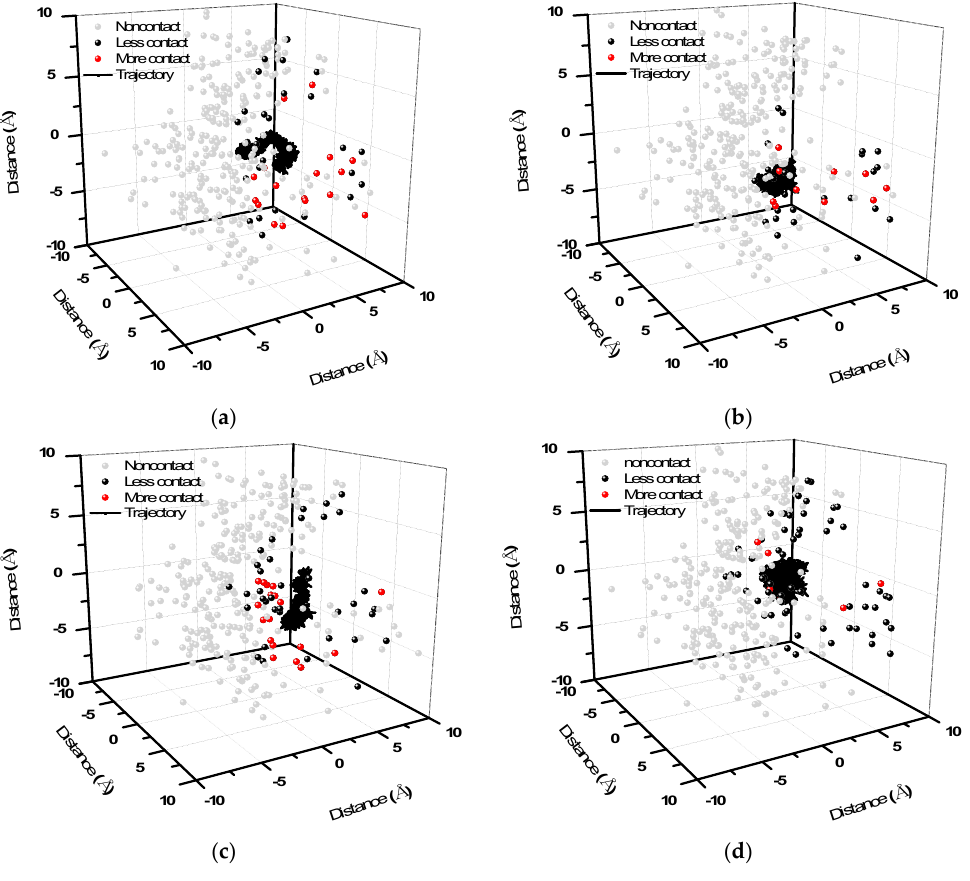
Figure 8. The 3D diagram of contact atoms around the ligand-binding domain in ( a ) PHF; ( b ) HMB; ( c ) DHMBP; ( d ) cerbinal system. The gray dots show the noncontact atoms around the ligand-binding domain. The black dots show the less contact atoms. The red dots show the more contact atoms. The black line shows the ligand trajectory during the simulation time.